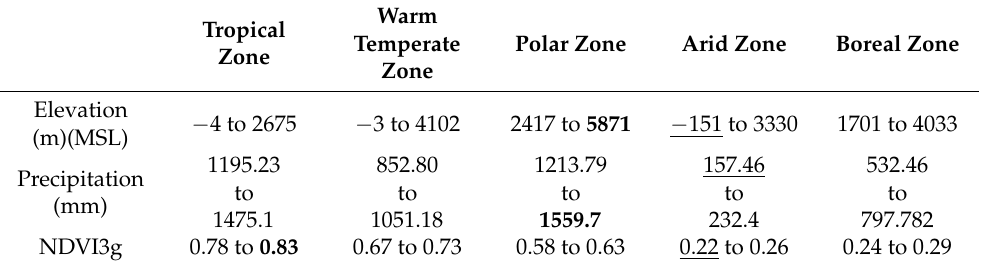
Table 3. Summary of altitude, annual mean climate, and NDVI3g data from 1982 to 2015. Warm Tropical Temperate Polar Zone Arid Zone Boreal Zone Zone